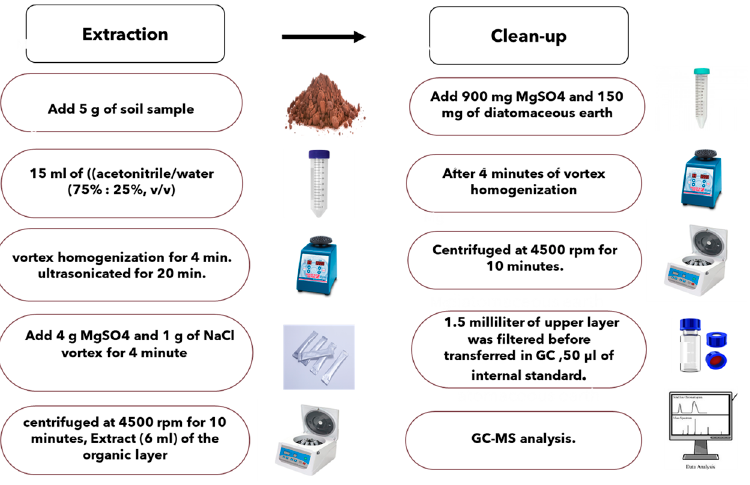
Figure 1. Schematic illustration of the modified QuEChERS extraction method.